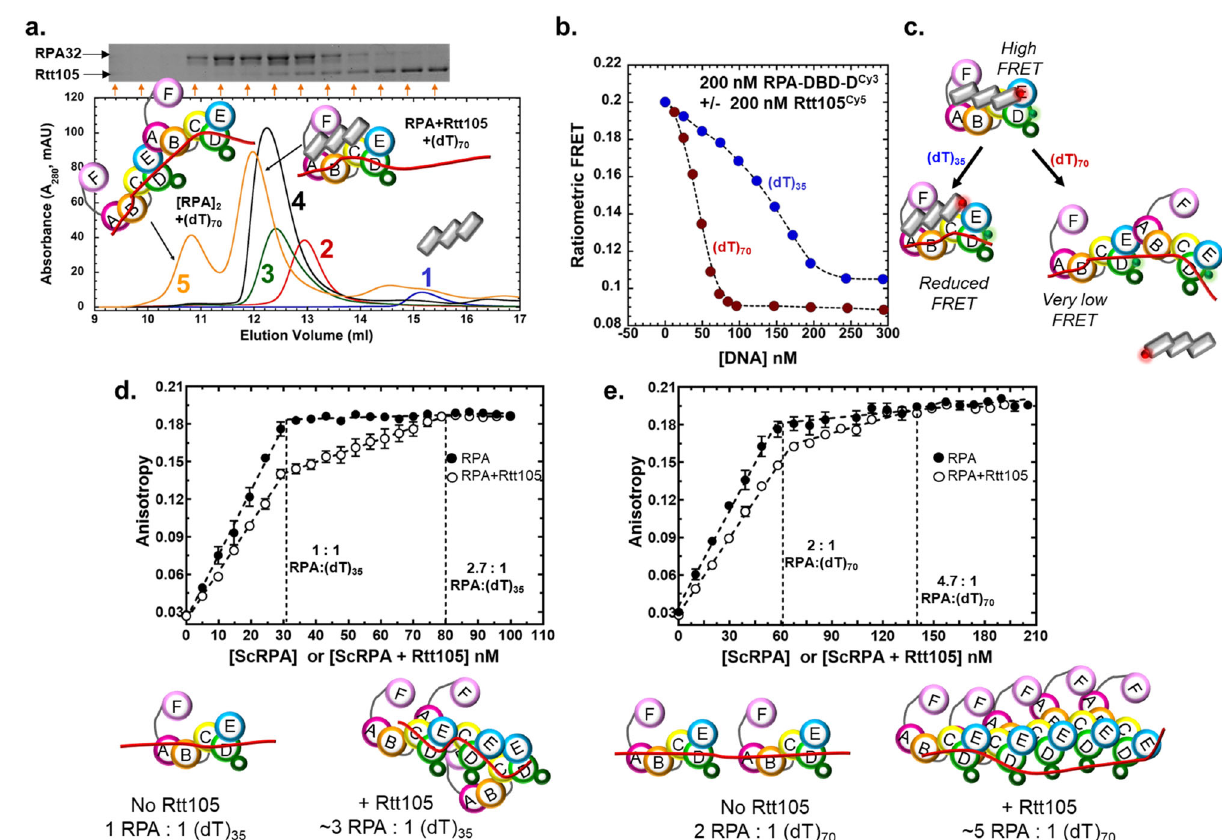
Fig.5|BindingofmultipleRPAmoleculesonlongerssDNAsubstratestriggers the release of Rtt105 and formation of a high-density RPA nucleoprotein fi la- ment. a Size exclusion chromatography (SEC) analysis of the Rtt105-RPA complex